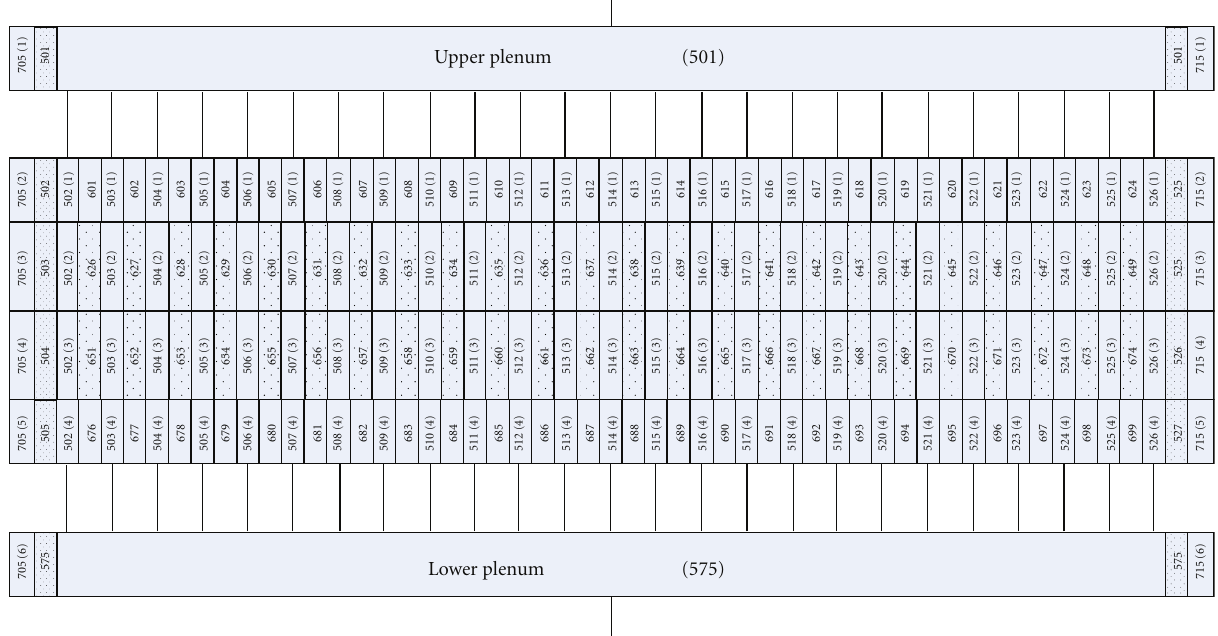
Figure 4: RELAP/SCDAPSIM nodalization of the MURR 24 fuel plate